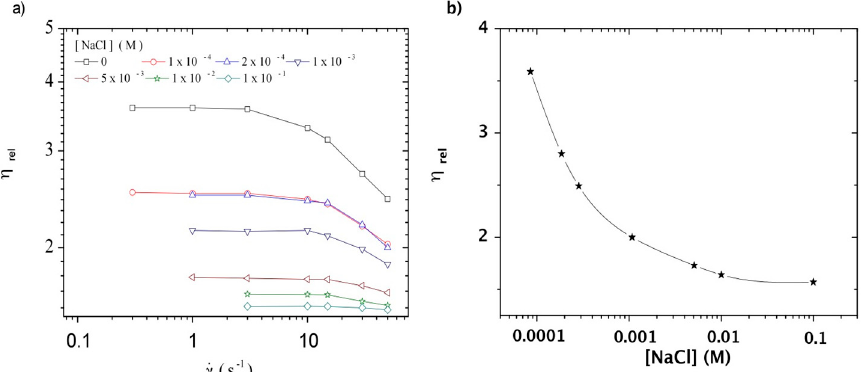
Figure 11. ( a ) Dependence of relative viscosity with the shear rate for a 0.2 mg/L DNA solution in NaCl as solvent at different ionic concentrations. Temperature: 20 °C; ( b ) Dependence of relative viscosity with [NaCl] for a 0.2 mg/mL DNA solution at a temperature of 20 °C.